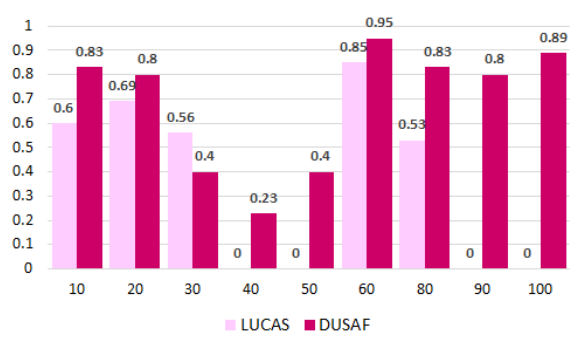
Bareland and Permanent Ice and Snow, which for LUCAS results are equal to 0, while for DUSAF they are 0.8 for both UA and PA.